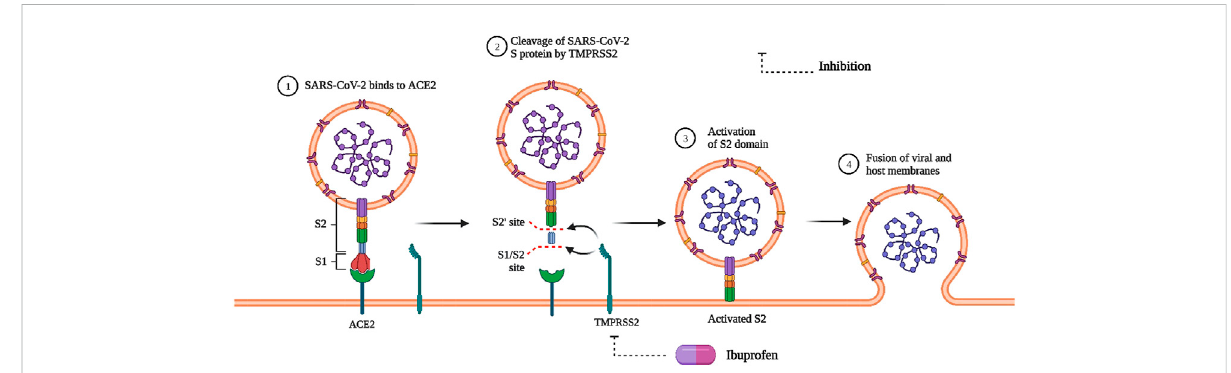
FIGURE 4 SARS-CoV-2 entry and effect of ibuprofen. ACE2 = Angiotensin converting enzyme 2, TMPRSS2 = Transmembrane serine protease 2, S1/S2 = SARS-COV-2 spike protein